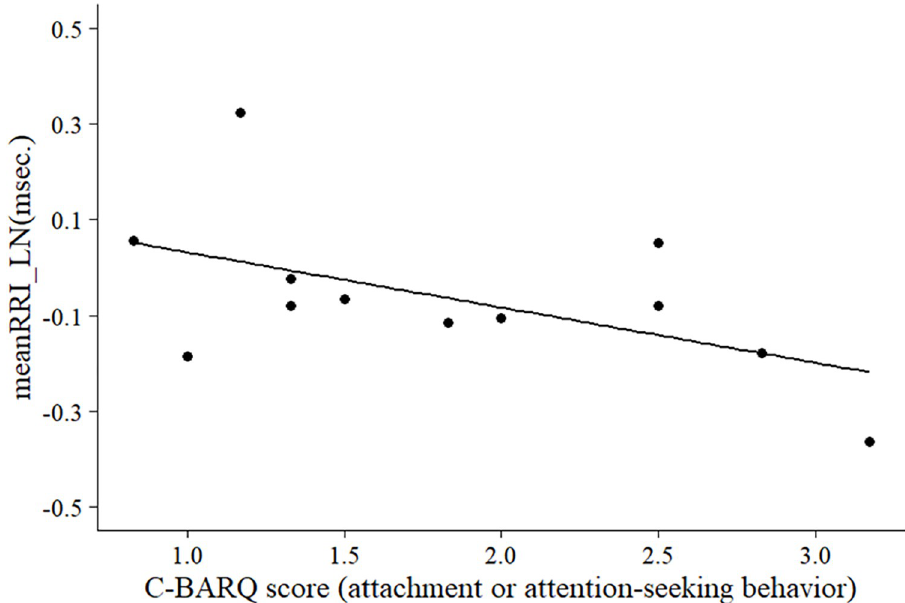
Fig 4. Correlation between C-BARQ score (attachment or attention-seeking behavior) and mean RRI (linear regression; β = -0.62, p <